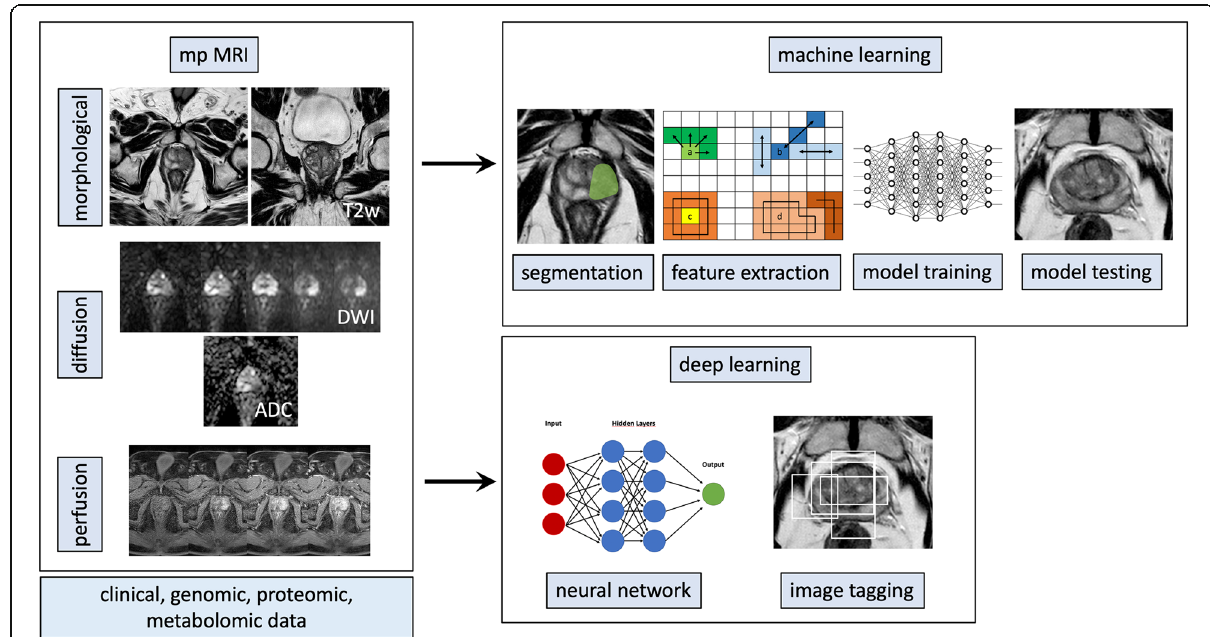
Fig. 2 Radiomic workflow pipeline for both machine learning and deep learning approaches for prostate magnetic resonance imaging. See the text for